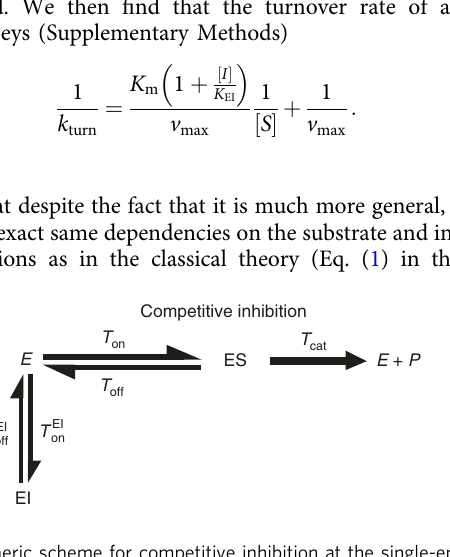
Fig. 3 A generic scheme for competitive inhibition at the single-enzyme level. Transition rates have been replaced with generally distributed transition times to generalize the Markovian scheme in Fig.